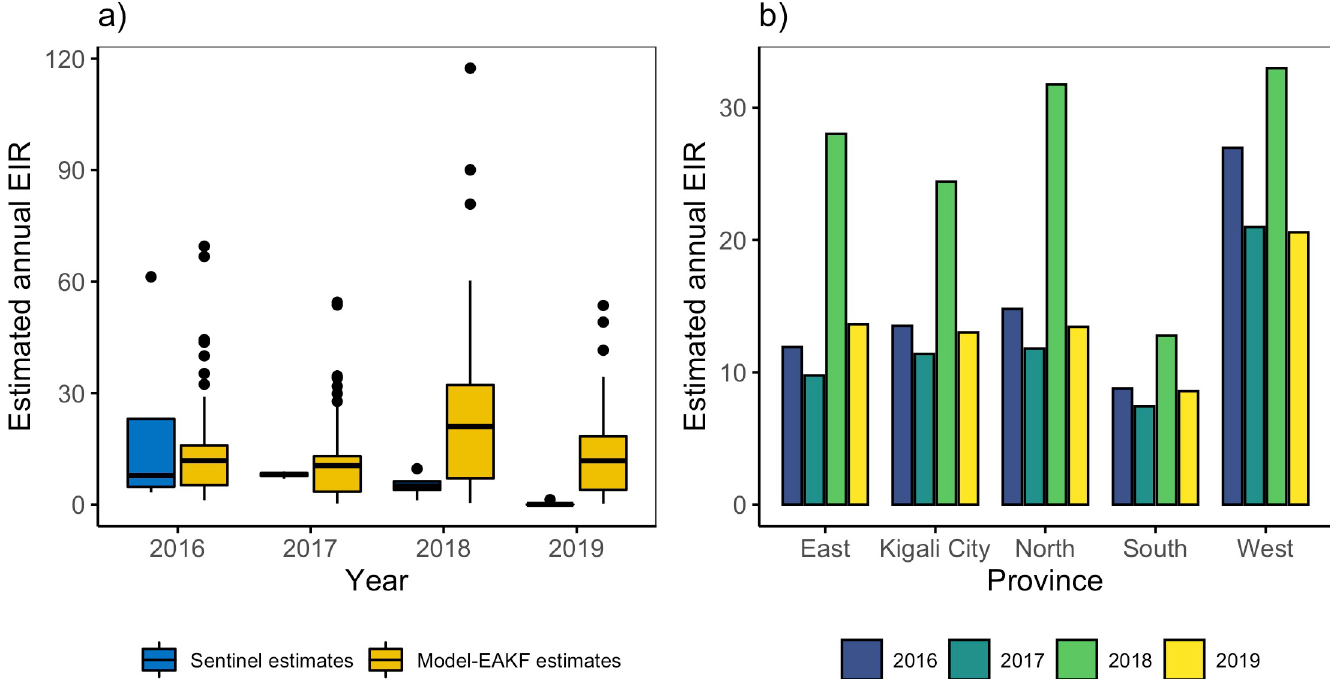
Fig 5. Estimates of the annual Entomological Inoculation Rate (EIR) across Rwanda 2016–2019. (a) Side-by-side boxplots of field estimated annual EIR from four entomology sentinel sites [32–35] across Rwanda (blue boxplots) and of model estimates of annual EIR for 42 study sites generated by continuous simulation of the model-EAKF system (yellow boxplots) for 2016–2019. (b) Average annual EIR at the province level aggregated from continuous simulation of the model-EAKF system at the site level. Blue, green, light green, and yellow colored bars represent 2016, 2017, 2018 and 2019, respectively.